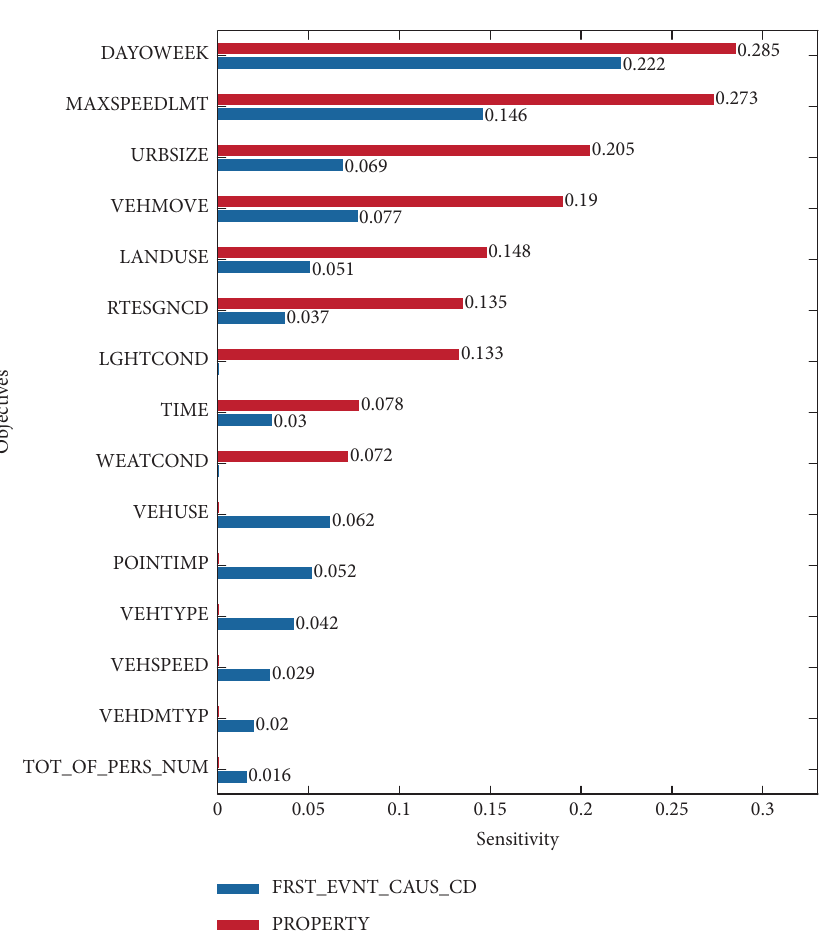
Figure 5: Sensitivity of each variable to two target nodes (PROPERTY and